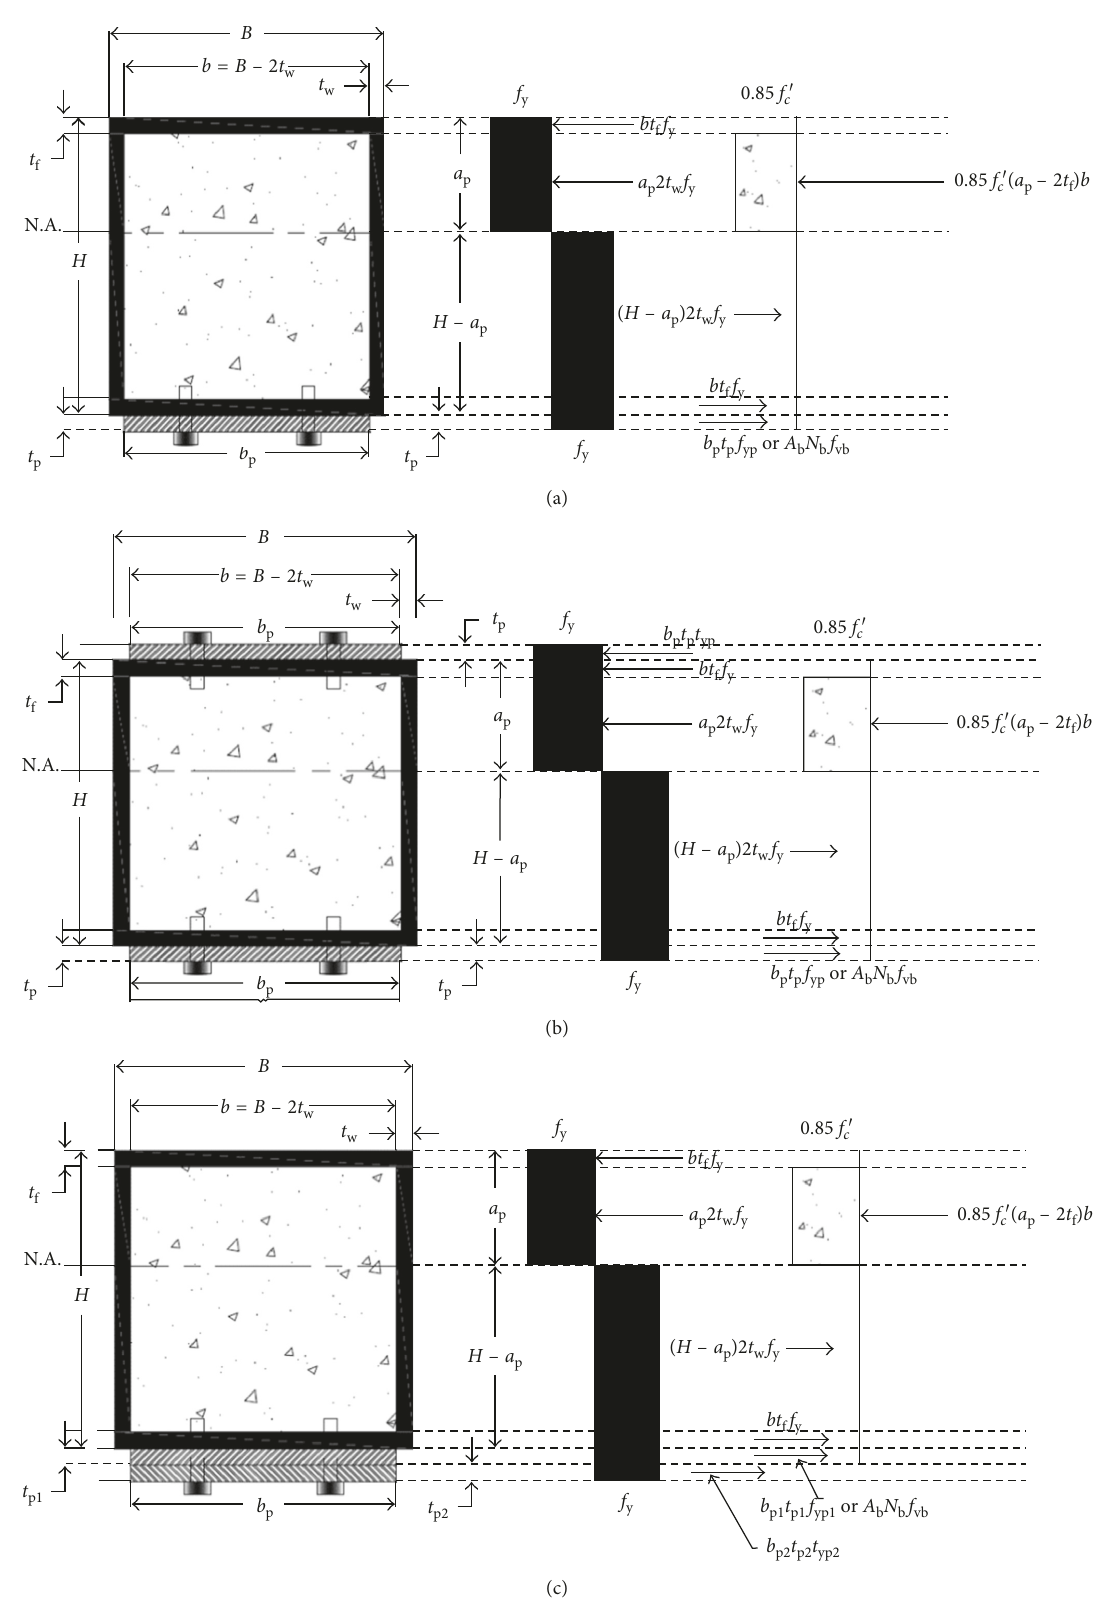
Figure 15: Theoretical model for calculating the ultimate moment capacity. (a) Stress blocks and forces for group A beams. (b) Stress blocks and forces for group B beams. (c) Stress blocks and forces for group C